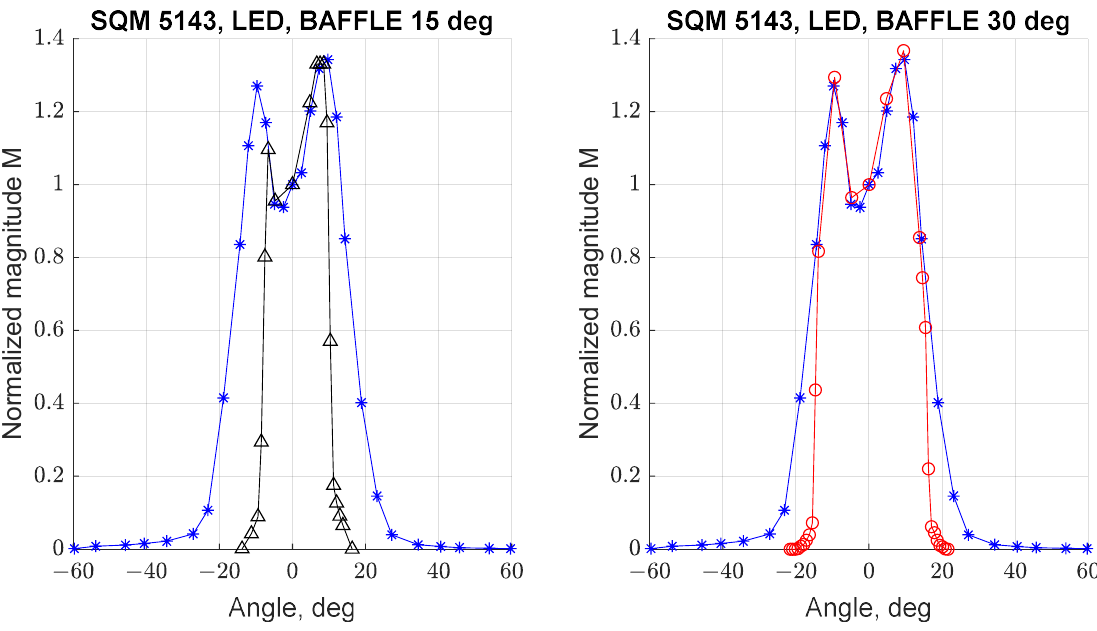
Figure 14. Effect of two different baffles on normalized angular response curves of SQM-LE 5143. On the left, 15 deg baffle (test 10, black line); on the right, 30 deg baffle (test 11, red line).